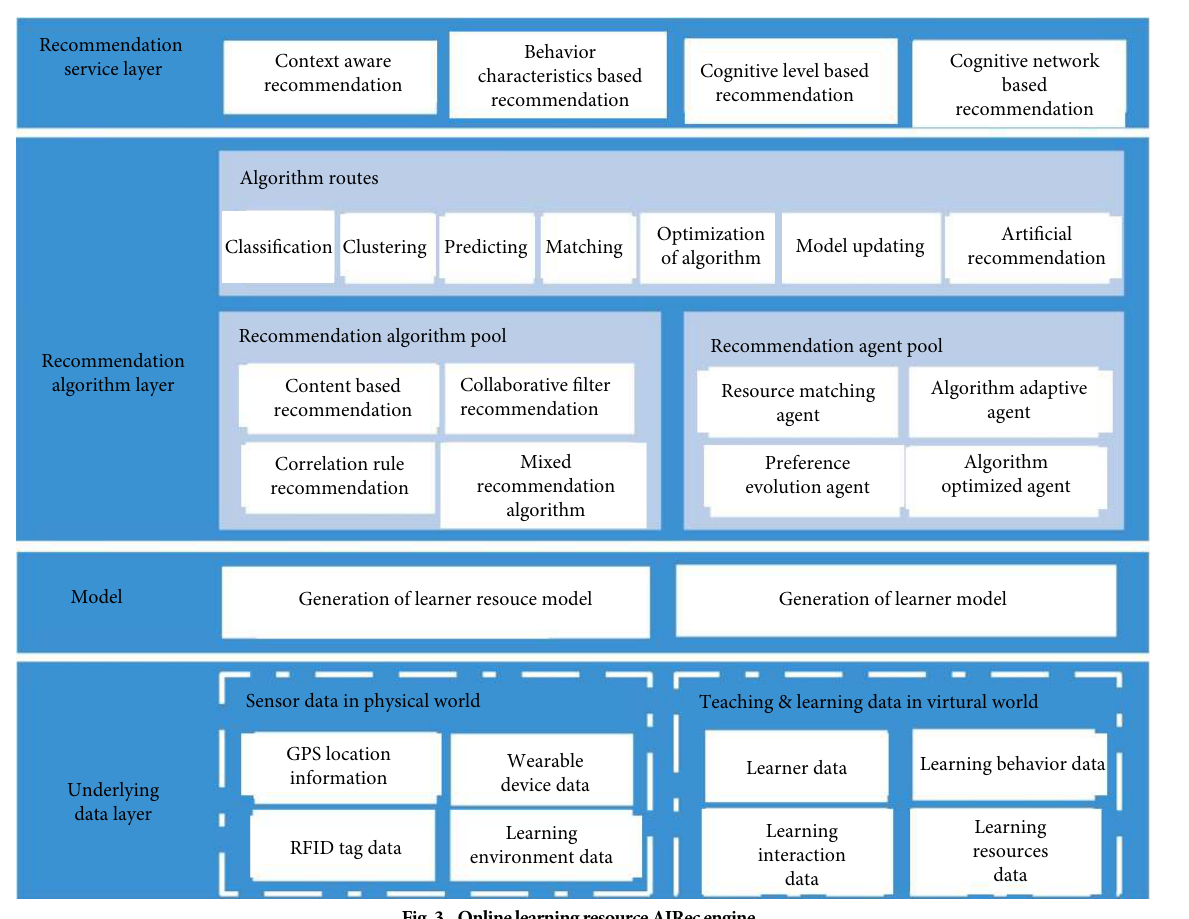
Fig. 3 Online learning resource AIRec